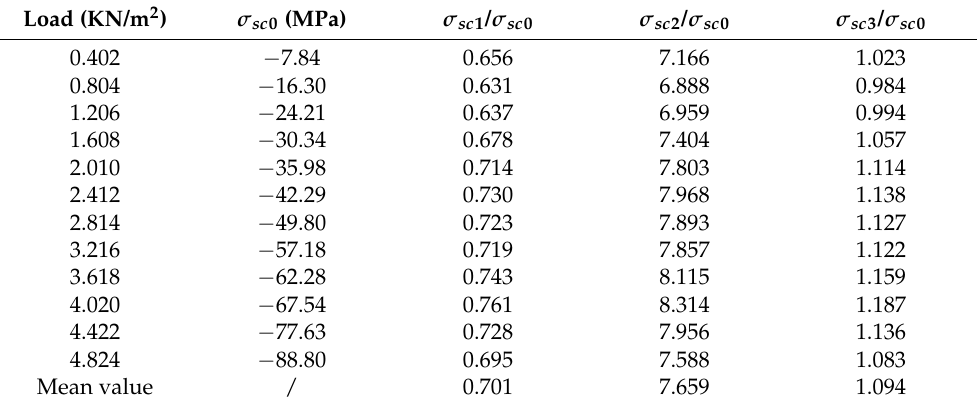
Table 9. Comparison of compressive stress at top flange of longitudinal light-gauge steel studs in